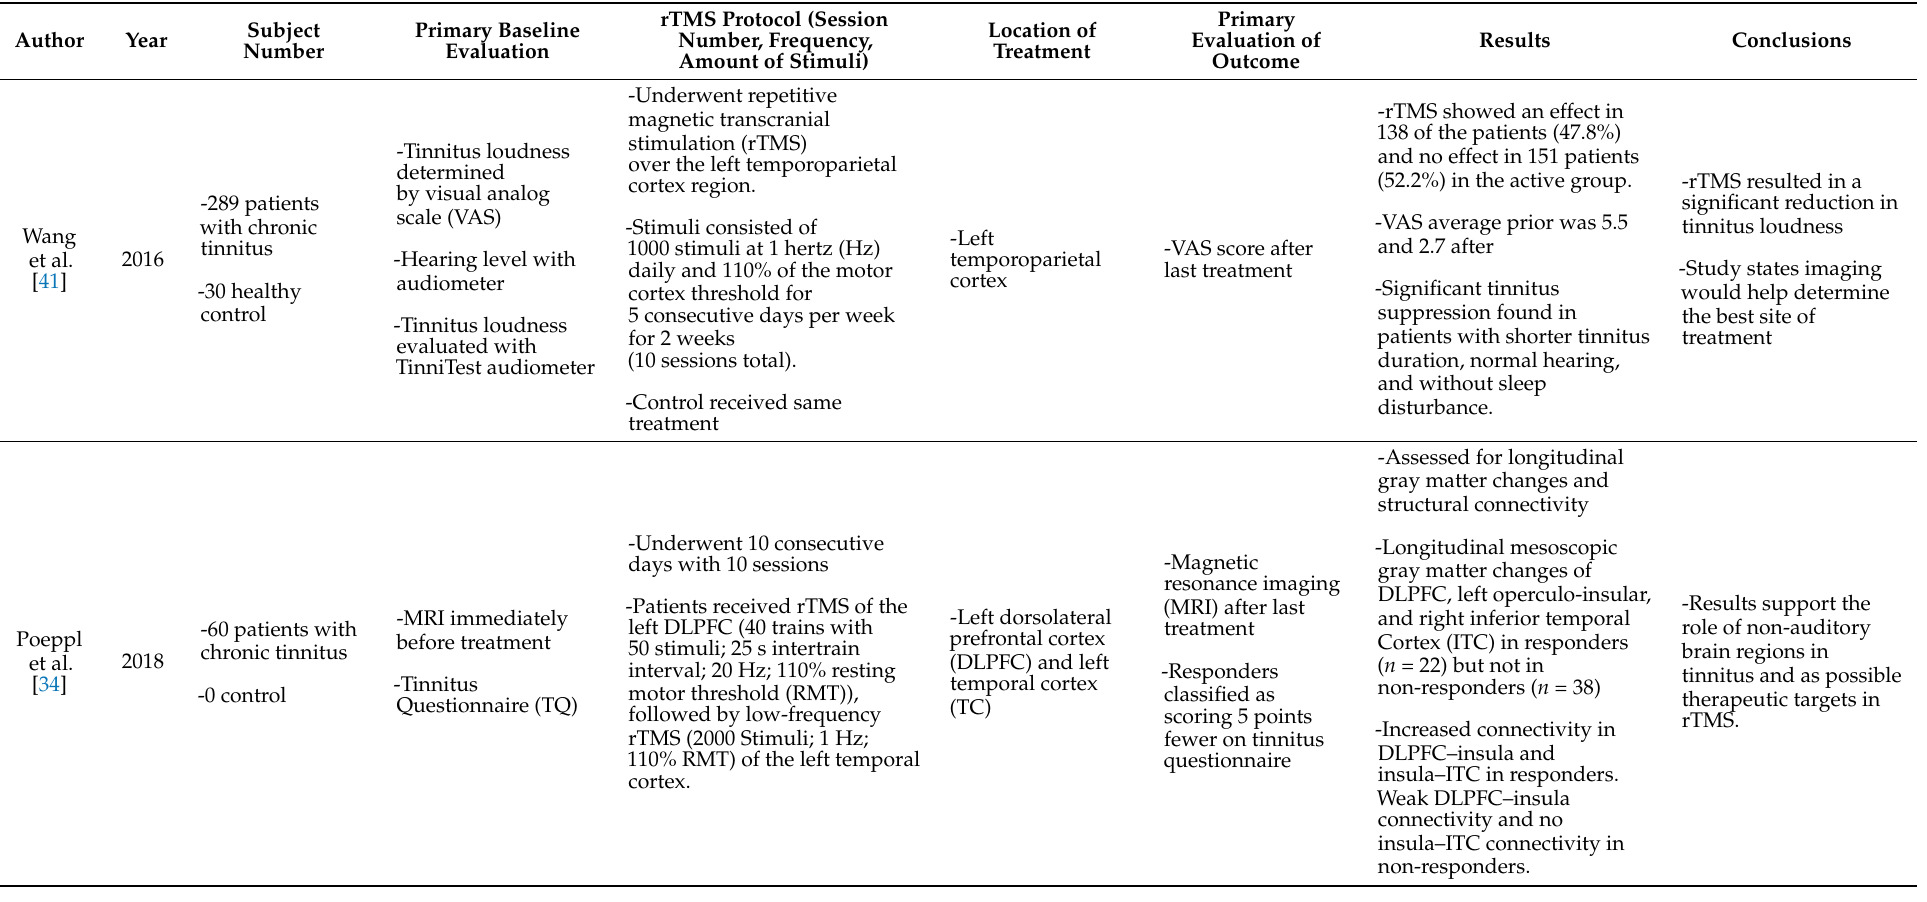
Table 1. Non-randomized studies: Summary of characteristics, protocols, results, and conclusions in 4 studies utilizing rTMS on patients with tinnitus without